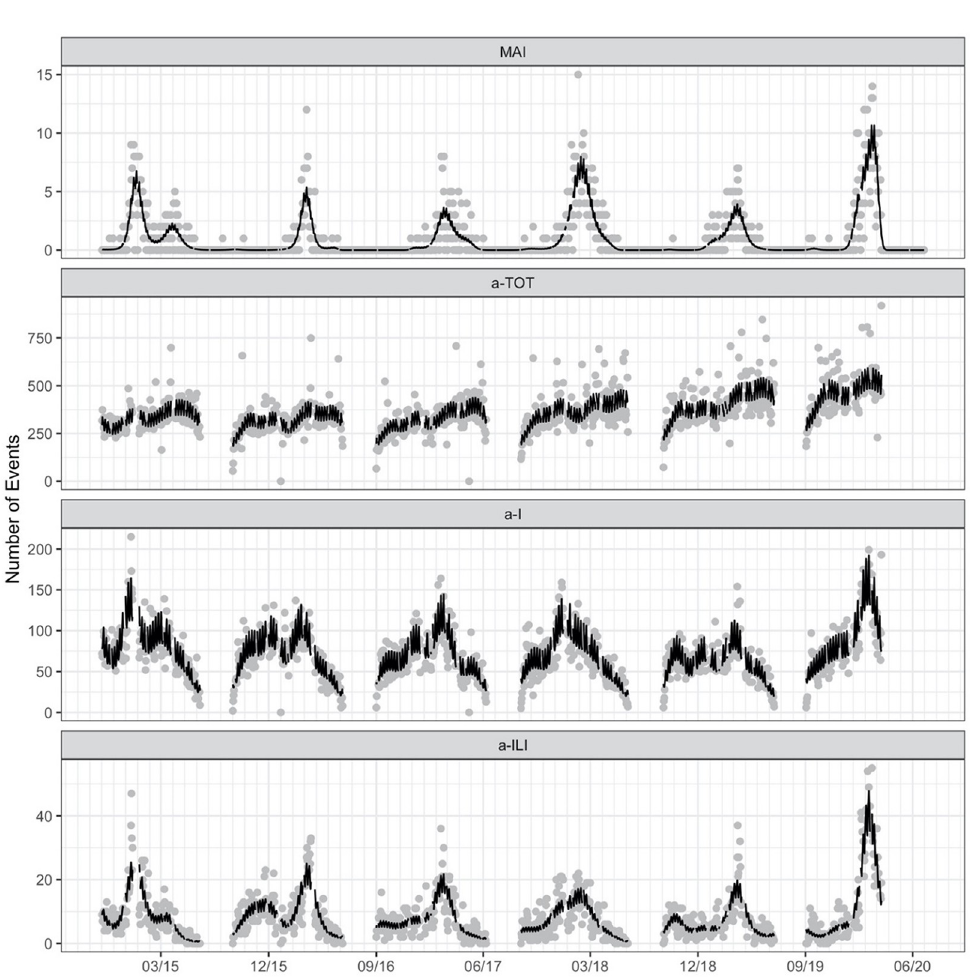
Fig 4. Numbers of daily student absences in each of three categories (a-TOT = absent for any reason, a-I = absent due to illness and a-ILI = absent due to influenza-like illness) and number of all-age medically-attended influenza (MAI) cases in surrounding communities during six school years/influenza seasons. The black line is the estimated mean number of daily events from a generalized additive quasi-Poisson regression model with calendar date (thin-plate spline) and day of week (dummy variables) as predictors. Gaps in the fitted curves represent breaks in the school calendar.